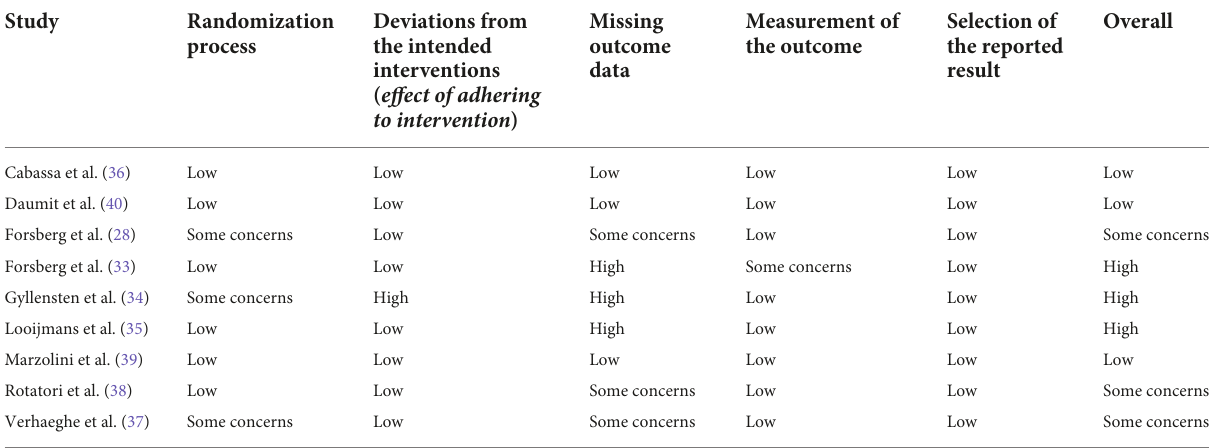
TABLE 1 Overview of the outcomes of the Cochrane Risk of Bias Tool